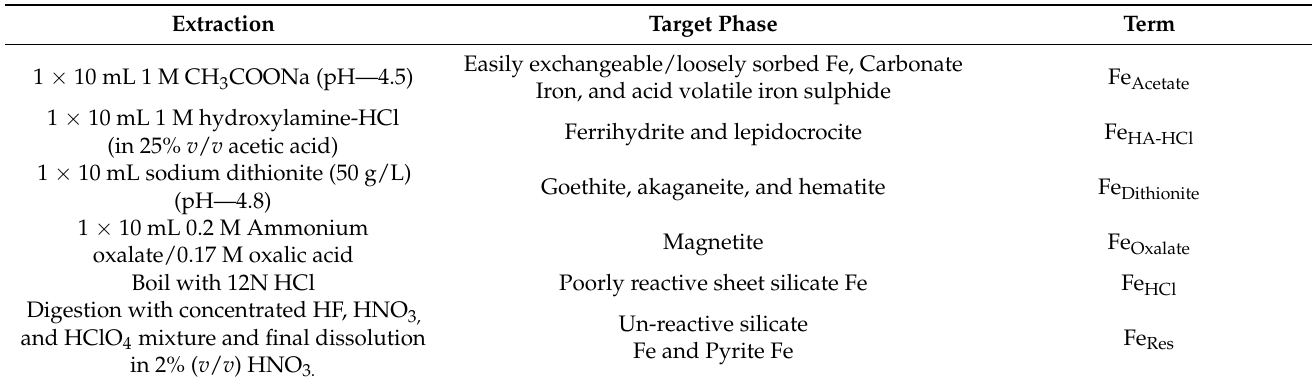
Table 1. The sequential chemical extraction protocol of Fe in sediments adopted from Poulton and Canfield